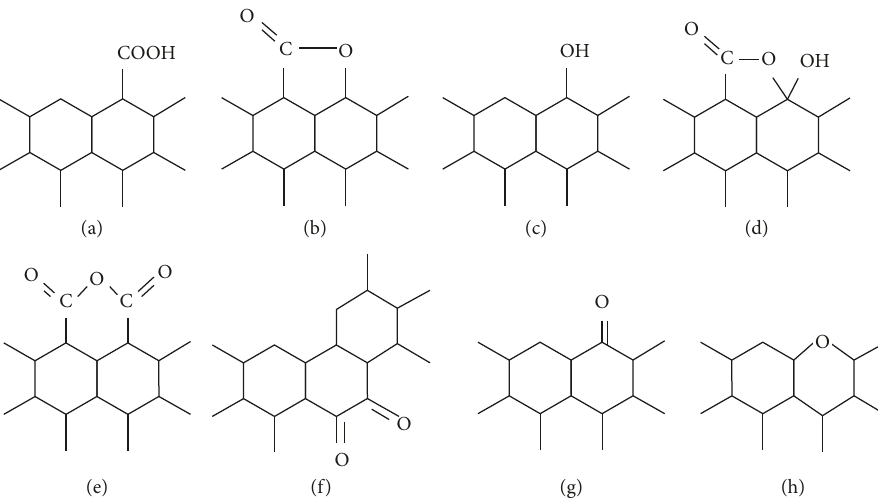
Figure 4: Surface oxygen groups on graphene edge: (a) carboxyl; (b) lactone; (c) hydroxyl; (d) lactol, (e) carboxylic anhydride; (f) quinone; (g) carbonyl; (h) ether.